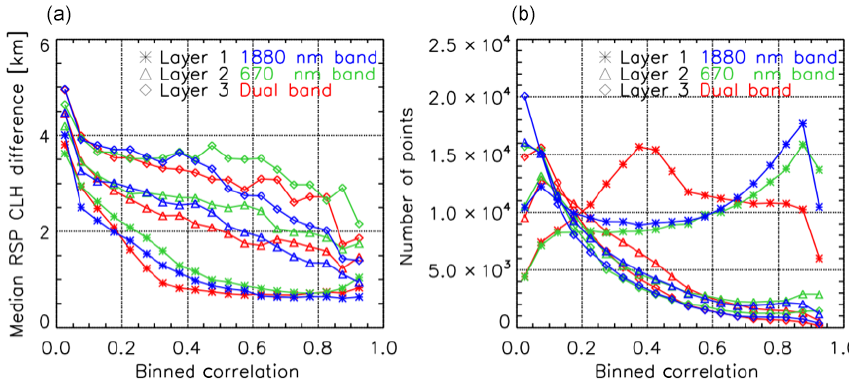
Figure 8. RSP CTH error (a) and number of samples (b) versus the minimum correlation for the 1880nm band (blue), 670nm band (green) and the dual band (red). The first, second and third layers are shown as stars, triangles and diamonds,